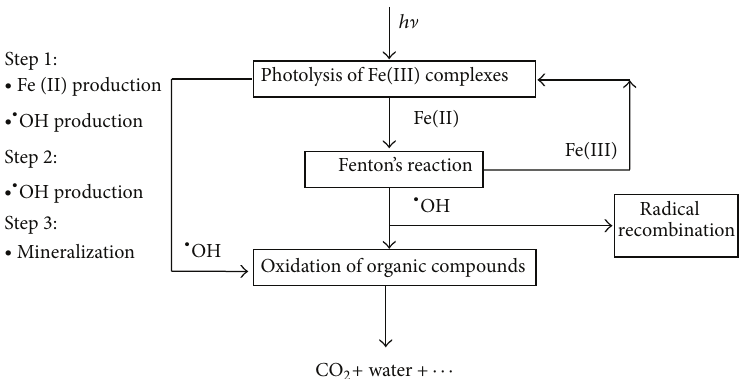
Figure 3: Reaction pathways of the photo-Fenton